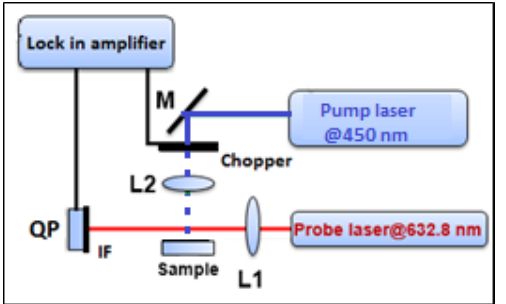
Figure 1. Schematic of the beam deflection spectroscopy (BDS) experimental setup. L1, L2: lenses, M: reflecting mirrors, IF: interference filter, QP: quadrant photodiode.